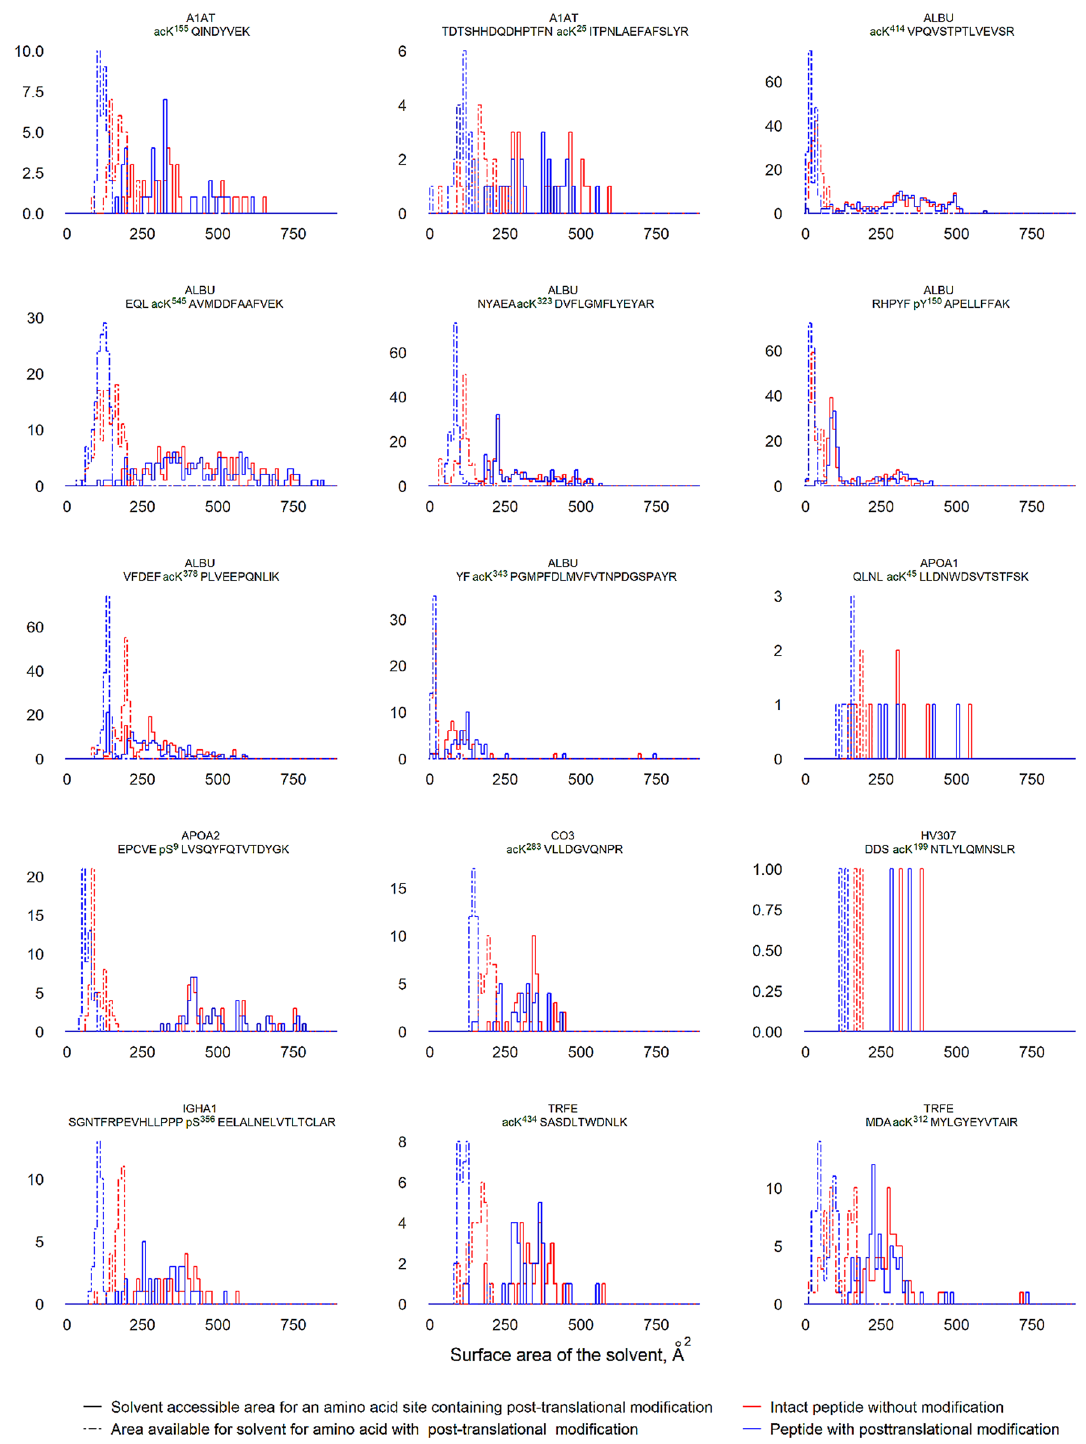
Figure 4. The distribution of proteins population with the identified PTMs depending on the solvent-accessible area for the certain amino acid residue and its active environment before and after mounting of PTM. The horizontal axis indicated the surface area, accessible for the surrounding solvent (in Å 2 ); the vertical axis indicated the number of the affected protein molecules. Color-code defines amino acids before modification (blue dashed line), amino acids after modification (pink dashed line), active environment before modification (blue solid line) and active environment after modification (pink solid